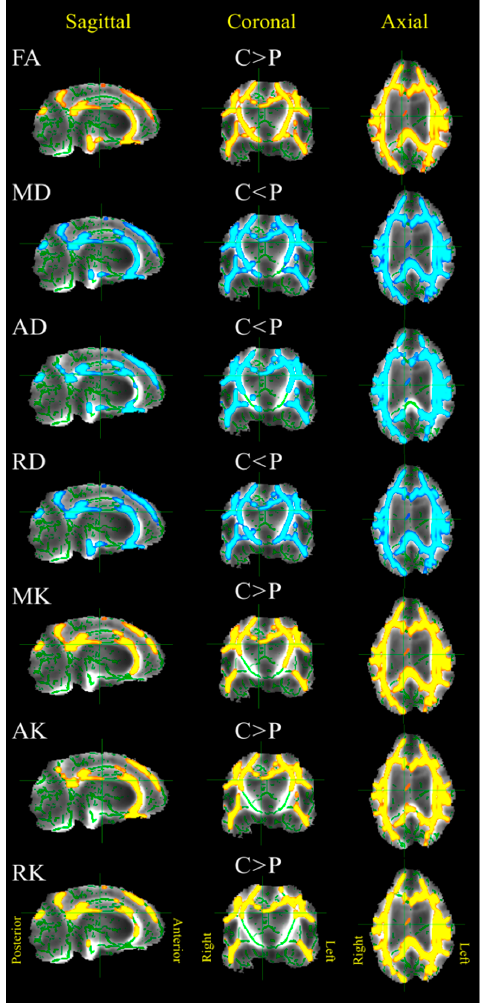
Figure 4. Tract-based spatial statistics (TBSS) results demonstrating locations of metric changes in patients (P) comparing to healthy volunteers (C) ( p < 0.05). The analysed white matter skeleton is shown in green with the colour overlays of significant differences. Yellow/red colour scheme represents the areas where the diffusion metrics of the patients were significantly lower than in the healthy control group; blue/light blue colour scheme is the areas where the diffusion metrics of the patients were significantly higher, respectively.